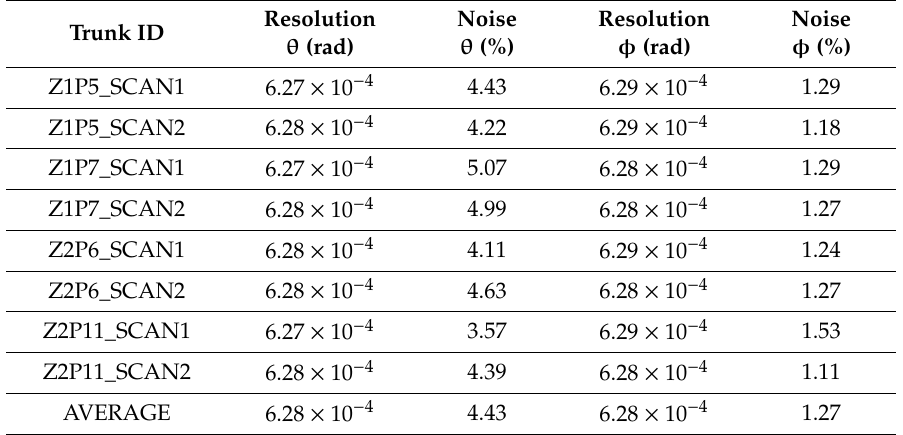
Table 4. Trunk ID, angular resolution and noise computed for TLS trunk data. Trunk ID